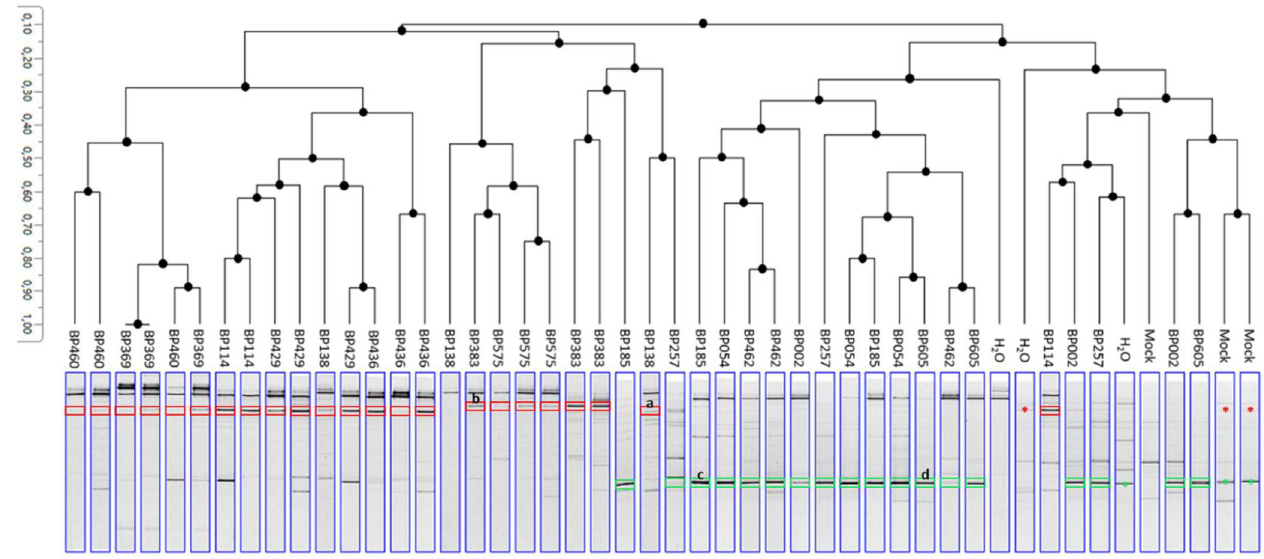
Figure 12. Dendrogram of PCR-DGGE profiles constructed by the UPGMA method. Red rectangles show Fusarium markers in Fusarium -inoculated fruitlets. Green rectangles show Talaromyces markers of Talaromyces -inoculated fruitlets. Red arrows indicate naturally present Fusarium sp. in control fruitlets. Green arrows indicate naturally present Talaromyces sp. in control fruitlets. BP138 and BP575: Fusarium sacchari ; BP383: Fusarium ananatum ; BP369 and BP460: Fusarium oxysporum ; BP114, BP429, and BP436: Fusarium proliferatum ; BP054, BP185, and BP462: Talaromyces stollii ; BP002, BP257, and BP605: Talaromyces amestolkiae . H 2 O: sterile water-inoculated samples; mock: No inoculation. Letters label DNA bands, which were sequenced.